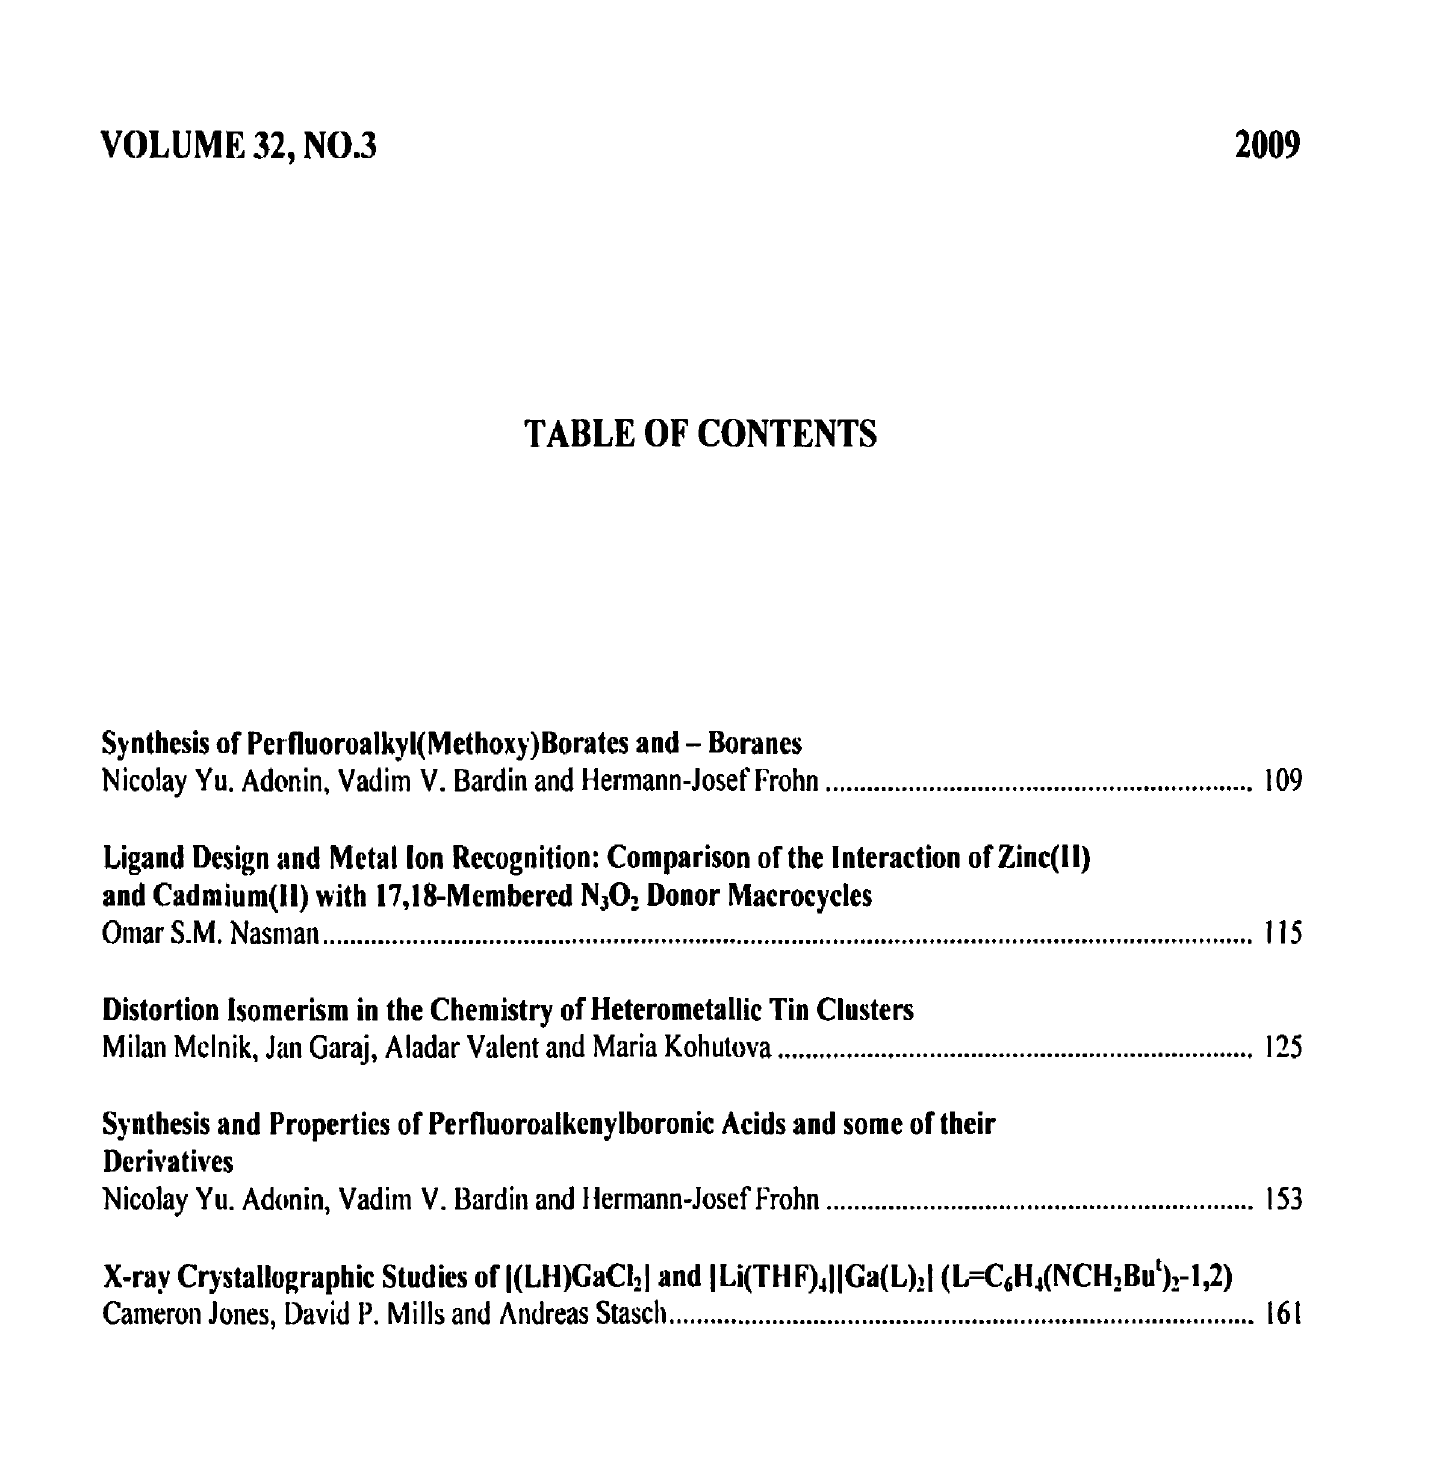
Synthesis of Perfluoroalkyl( Met hoxy) Borates and -